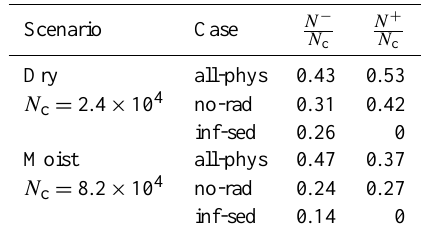
Table 1. The number of cloudy air parcels N c , and the fraction of parcels within the set N c that are dehydrated and hydrated in all model